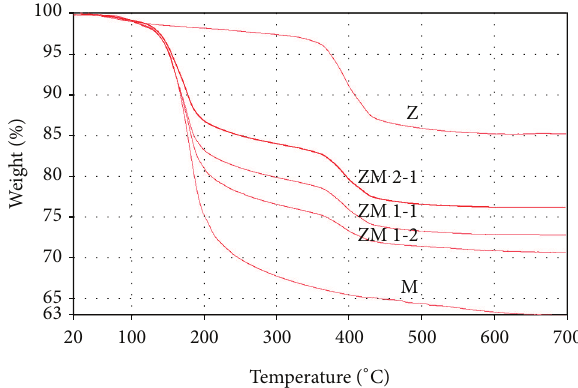
Figure 7: TG of the synthesised optimum phases of the magnesium and zinc borates and mixtures of the magnesium and zinc borates.